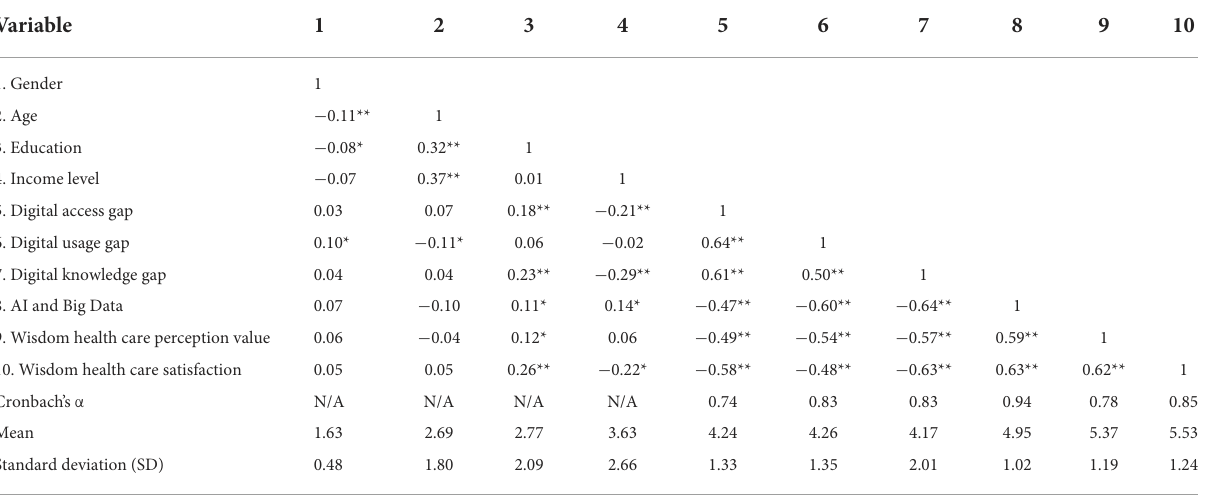
TABLE 2 Means, standard deviations, and